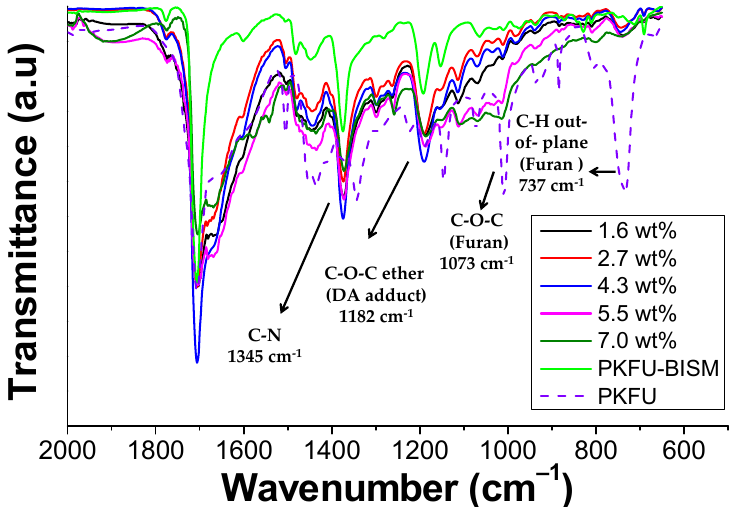
Figure 5. FT-IR spectra of the modified non-cross-linked polymer (PKFU), modified cross-linked polymer (PKFU-BISM), and of the modified cross-linked nanocomposite (PKFU/BISM/rGO) .